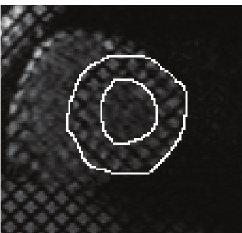
Figure 2: Manual detection of epicardial (external circle) and endocardial (internal circle) boundaries of the Left Ventricle (LV) on a Short-Axis-Tagged MRI acquisition.